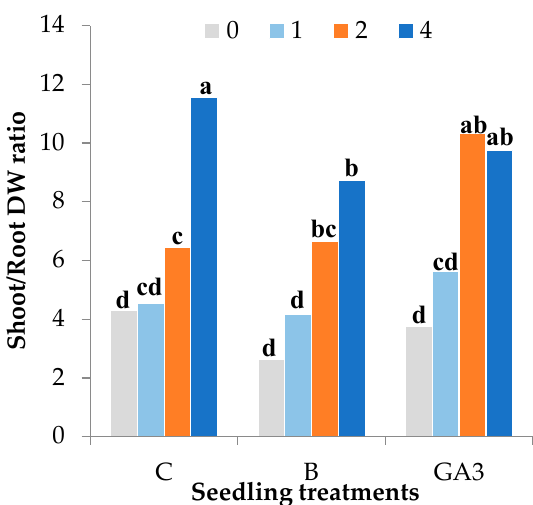
Figure 5. Effect of the seedling treatments (C, untreated control, B, bacterial biostimulant, GA3, gibberellic acid spray 10 − 5 M) and the nursery fertigation rates (0, 1, 2 and 4 g L − 1 of NPK 20-20-20) on the shoot / root fresh weight ratio of Solanum lycopersicum ‘Marmande’ seedlings (bars with different letters are significantly different at p < 0.05 according to the LSD test).